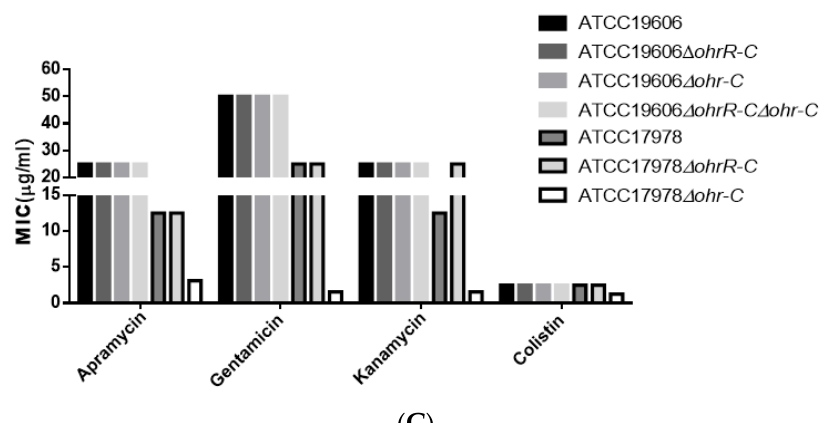
Figure 3. Growth curve of different A. baumannii strains in LB medium and minimum inhibition concentration (MIC) of different strains treated by different antibiotics. Growth curve of ( A ) A. baumannii ATCC 19606 and ( B ) A. baumannii ATCC 17978 wild-type and mutant strains. The Y -axis at left represents OD 600 , while the Y -axis at right represents viable cell count. Filled symbols represent the optical density and empty symbols indicate the viable cell counts of each strain. These data were obtained from three independent experiments. ( C ) MIC of different strains.